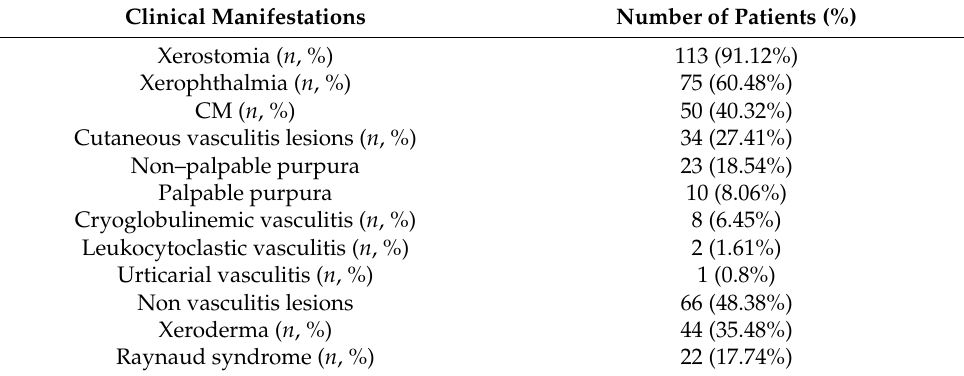
Table 2. Cutaneous manifestations in pSS patients.